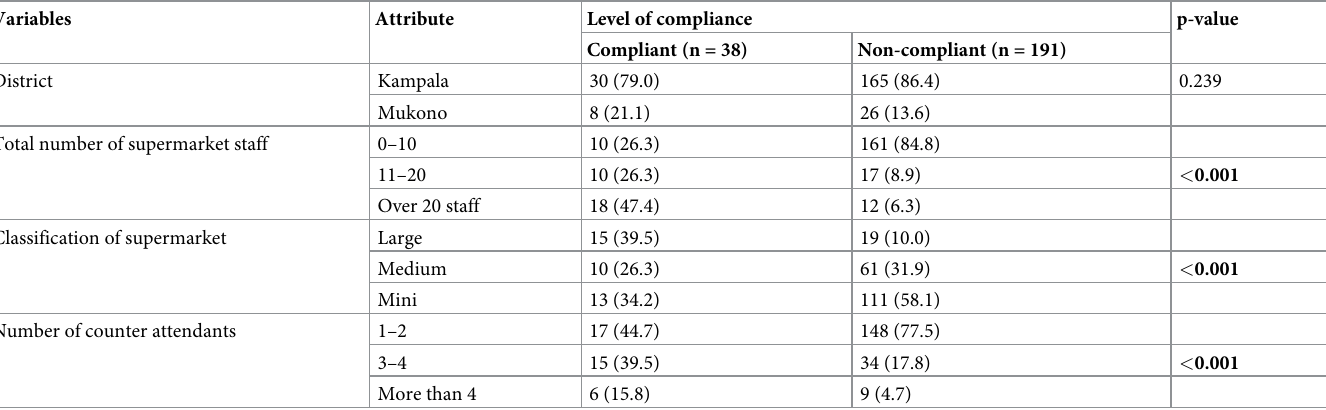
Table 6. Level of compliance to COVID-19 guidelines stratified by supermarket